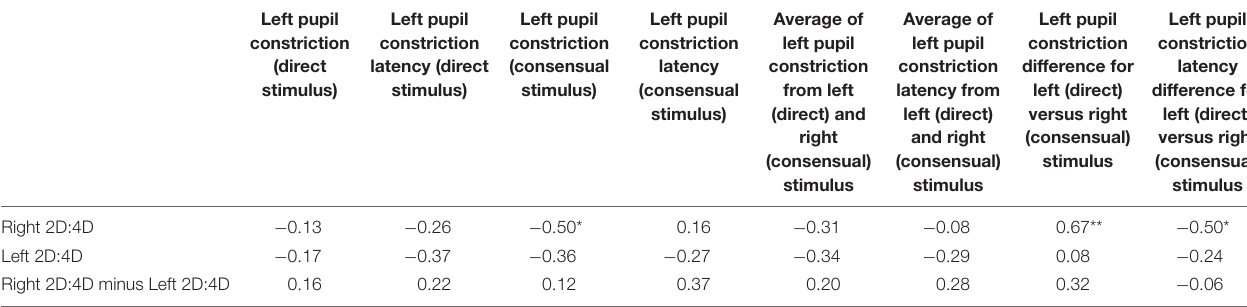
TABLE 2 | Study 2 correlations for digit ratios with pupillometry data.